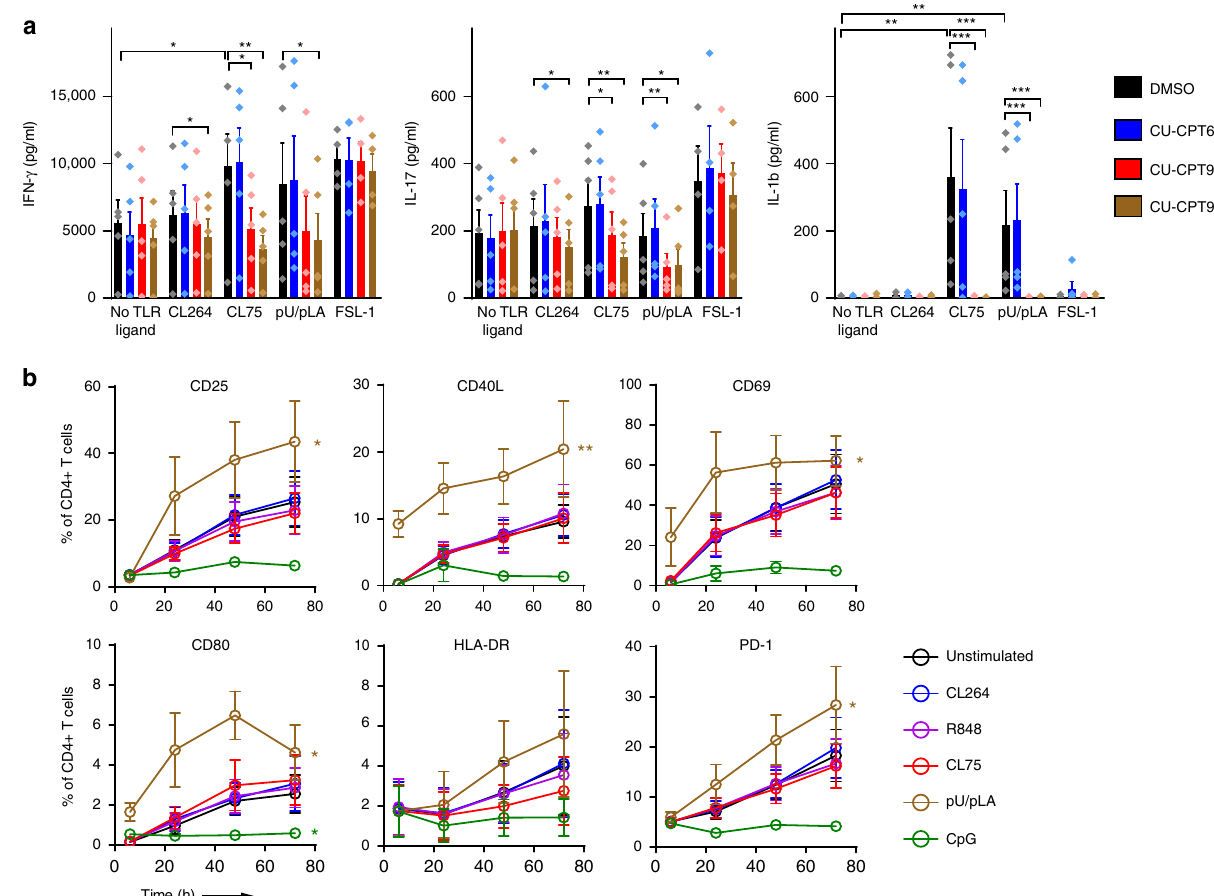
Fig. 3 TLR8 enhances cytokine secretion and surface activation markers in CD4 + T cells. a CD4 + T cells were pre-treated with 5 µ M TLR8-speci fi c inhibitors CU-CPT9a, CU-CPT9b, or the negative control compound CU-CPT6, prior to TCR activation and stimulation with synthetic TLR ligands (5 µ g/ml). Cell supernatants were harvested at 24 h and IFN- γ , IL-17, and IL-1 β analyzed using multiplex ELISA. Bars represent mean values + SEM from fi ve independent experiments. b TCR-activated CD4 + T cells were stimulated with 5 μ g/ml CL264, R848 (TLR7/8), CL75, pU/pLA, or CpG (TLR9, 5 μ M). T cell activation markers were analyzed by fl ow cytometry at the indicated time points after surface staining for CD25, CD40L, CD69, CD80, HLA-DR, and PD-1. Graphs represent mean values ± SEM from three independent experiments. Statistical signi fi cance was determined in a by ANOVA with Dunnett ʼ s post-test, in b by area under the curve (AUC) calculation followed by one-way ANOVA with Dunnett ʼ s post-test on log-transformed data; signi fi cance levels: * p < 0.05; ** p < 0.01; *** p < 0.001. Source data are provided as a Source Data